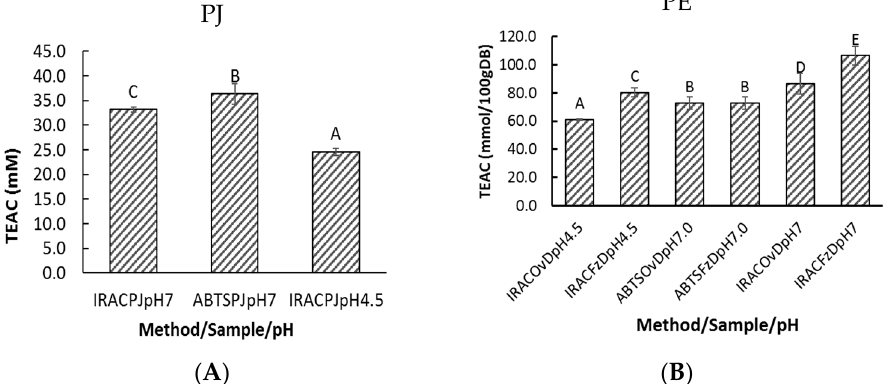
B Figure 1. Typical time course traces for absorbance readings at 562 nm (A562) for iron (III) reducing antioxidant capacity ( iRAC ) method; ( A ) Gallic acid (GA500), vitamin C (VITC500), or trolox (TX500) were reference compounds (500 uM), ( B ) Timed response for pomegranate juice or pomegranate extracts (5 g/100 mL) prepared with 40:60 v / v methanol/water) and diluted 100× before analysis. PJ100 = pomegranate juice, OVD100 = extract from oven-dried sample, FD100 = extract from freeze-dried sample.